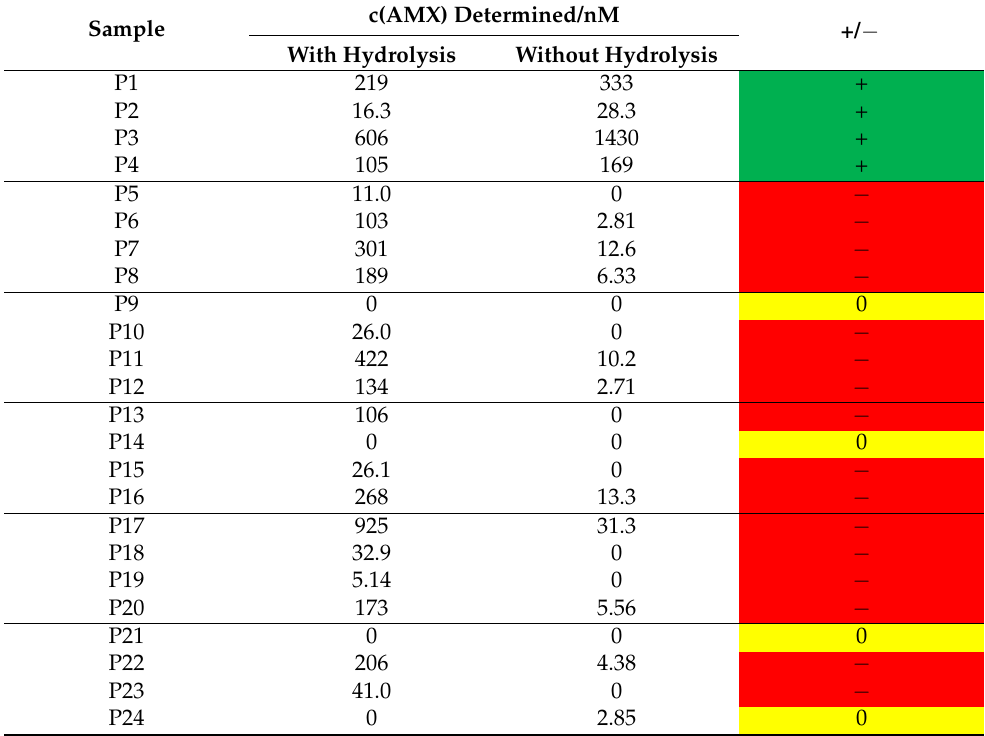
Table 2. Comparison of AMX concentrations determined by ELISA with and without hydrolysis allowing for assessment of AMX hydrolysis degree in the water samples (“+”: hydrolyzed; “ − ”: unhydrolyzed; “0”: blank/false negative).